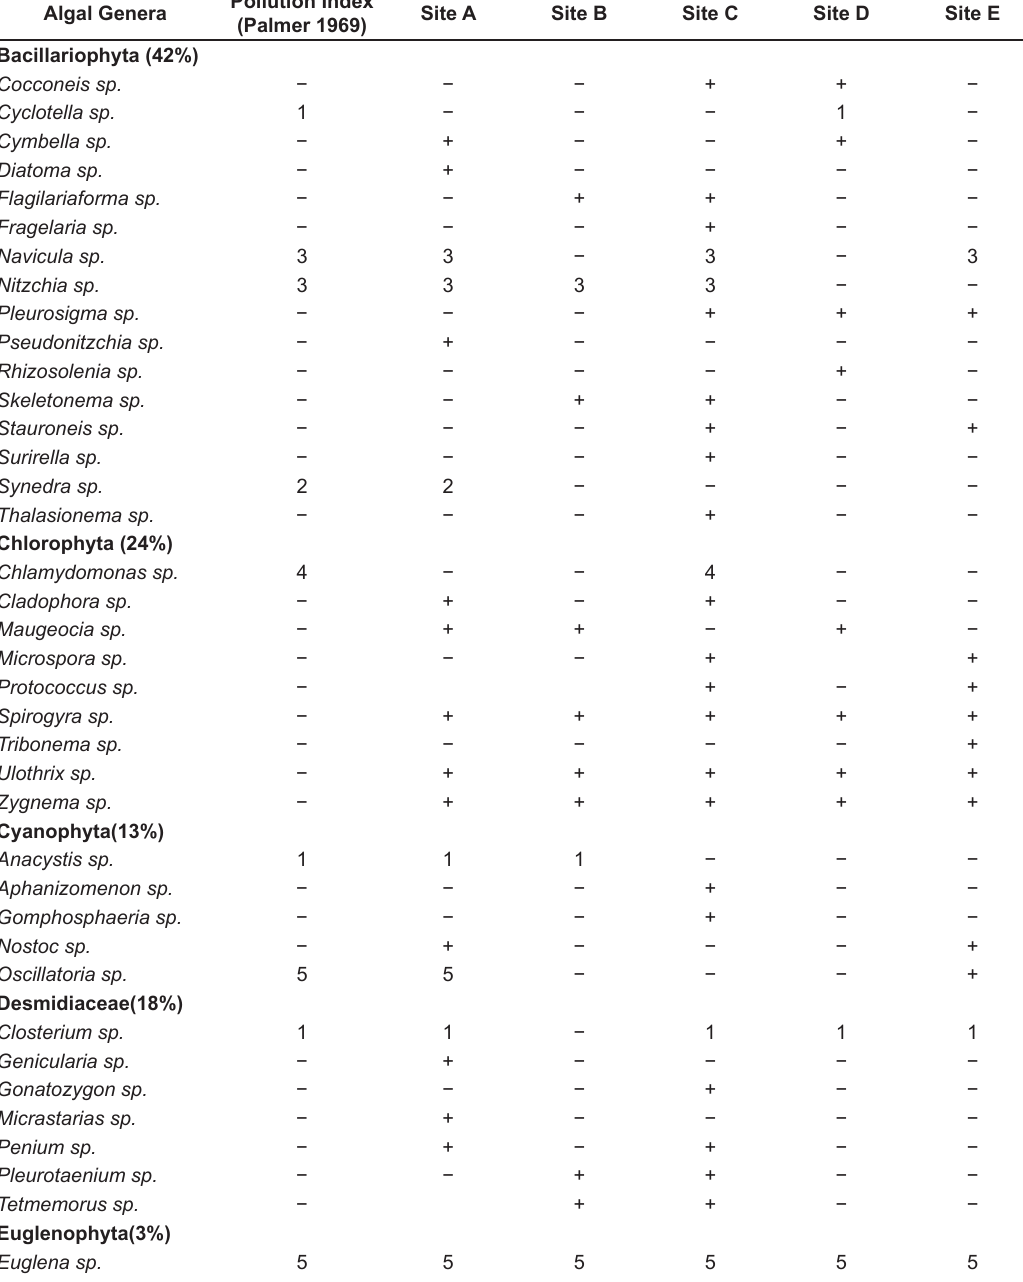
Table 3. Pollution index of Algal genera according to Palmer, (1969) at Five Sites of Nasarawa Reservoir. Algal